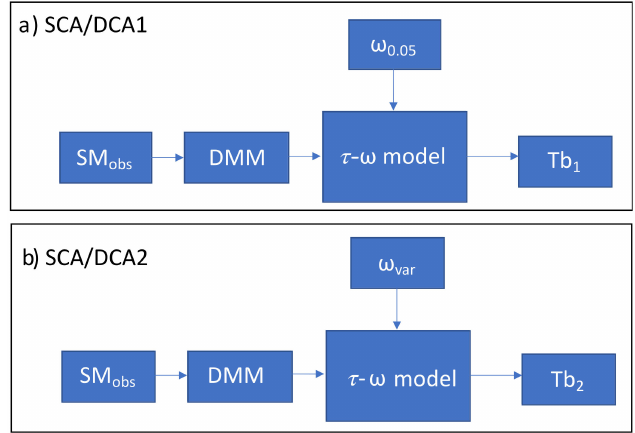
Figure1. Simulationofbrightnesstemperatures( Tb )usingthe( a )classical τ - ω modelwithtime-constant ω , ( b ) time-varying parameterization of the τ - ω model with variable ω (DMM: dielectric mixing